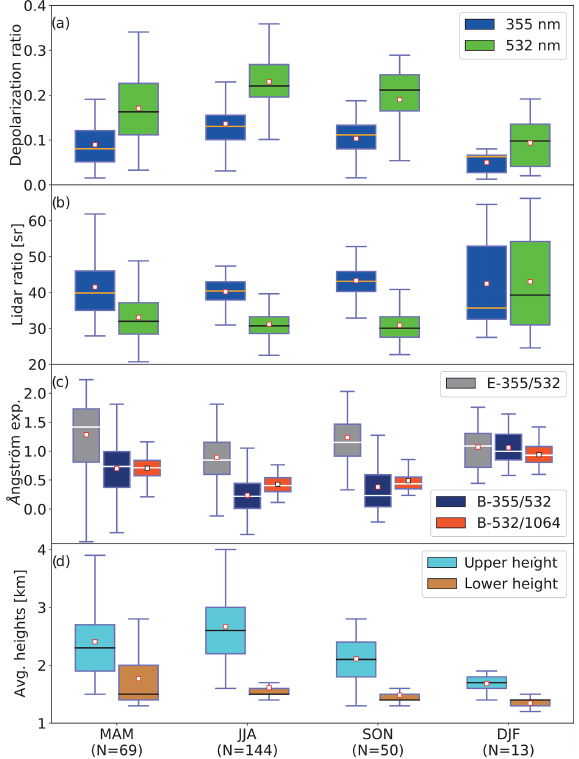
Figure 5. Boxplots of layer-mean (a) particle linear depolariza- tion ratio and (b) lidar ratio at 355 and 532nm wavelength, (c) of extinction-related (E-355 / 532) and backscatter-related (B- 355 / 532, B-532 / 1064) Ångström exponents, and (d) of lower and upper boundaries of the respective signal averaging layers for which the optical properties are computed. The statistical results are given for spring (MAM), summer (JJA), autumn (SON), and winter (DJF) with number of observations in brackets. The box indicates the interquartile range (IQR), in which 50% of the data accumulate. Seventy-five percent of the data points are within the range indi- cated by the whiskers (1.5IQR). Seasonal mean and median values are given as open squares and horizontal lines,